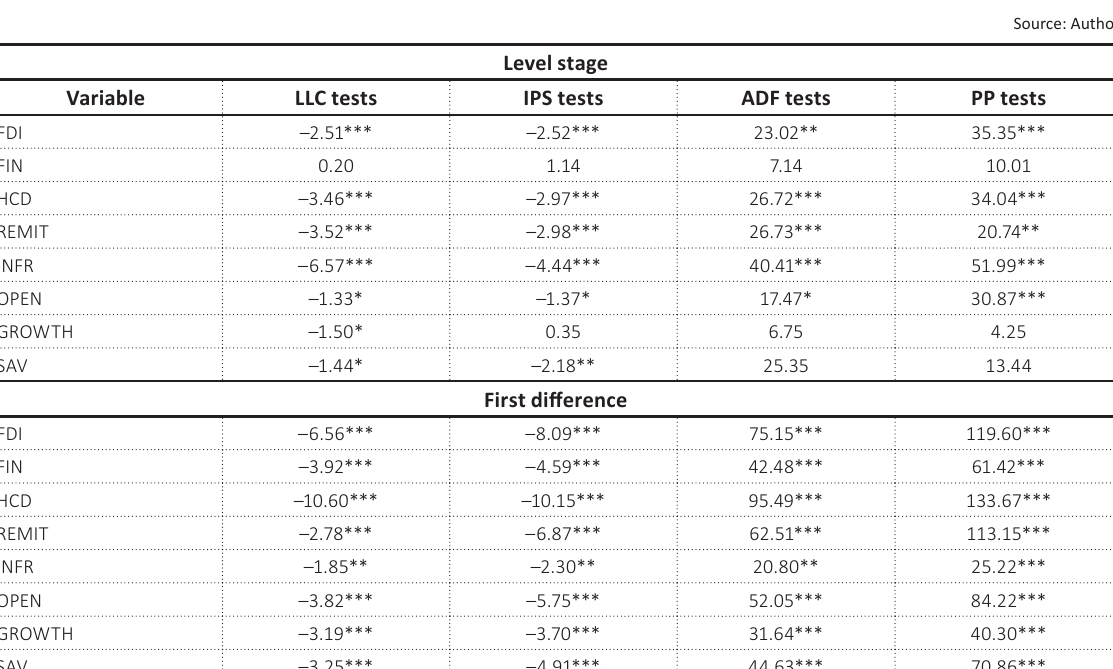
Table 4. Stationarity tests (Individual